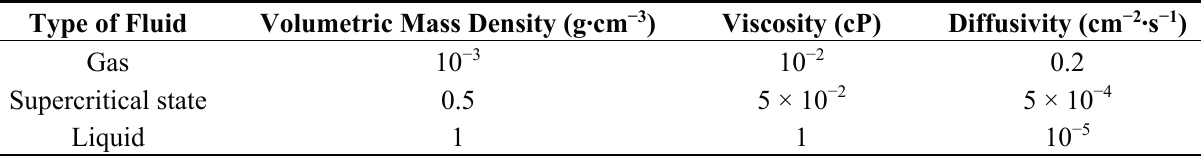
Table 1. Order of magnitude of physical properties for gas, supercritical fluid and